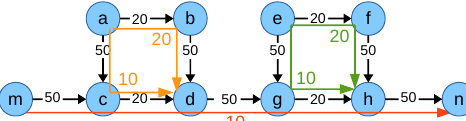
Figure 10. Scenario from Figure 9, but NFF-objective-III enforces multipath for flows [ a,d ] and [ e,h ] and as a result restricts flow [ m,n ]